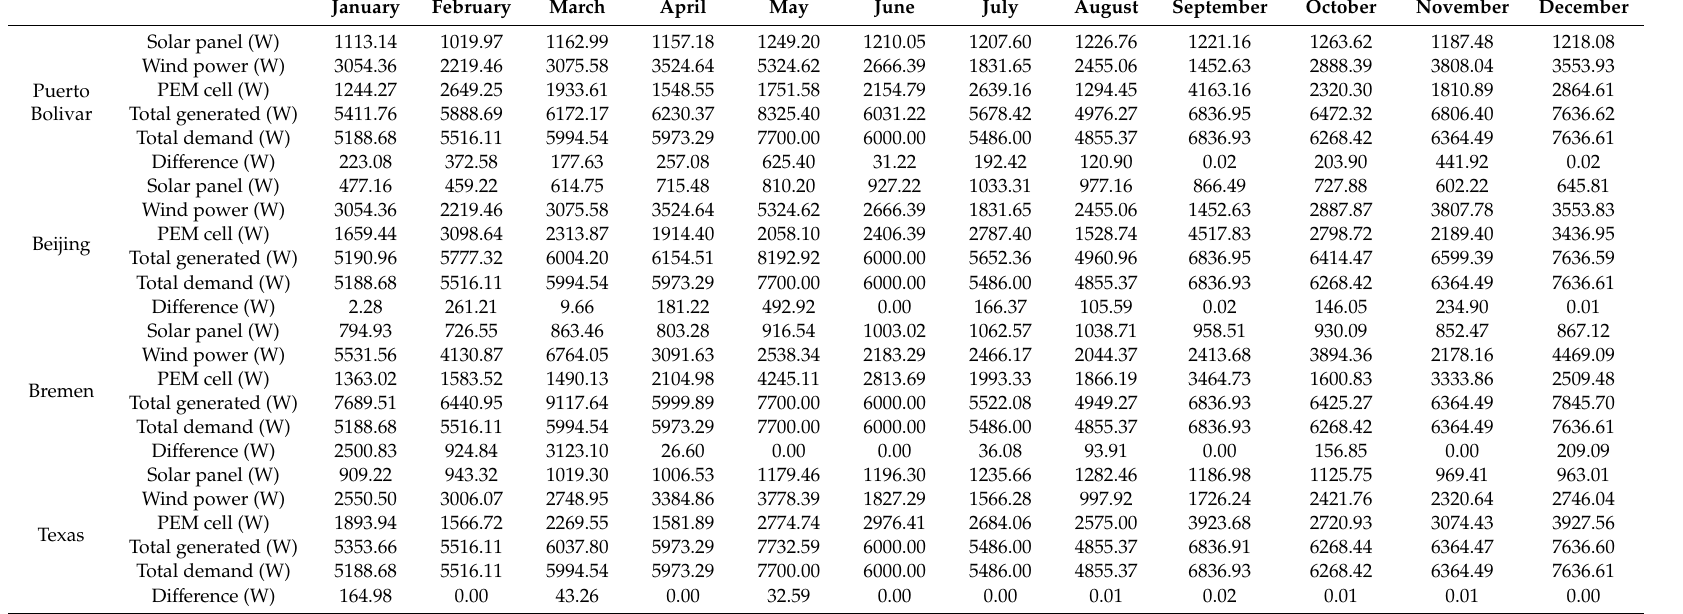
Table 7. Monthly generated renewable energy for demand